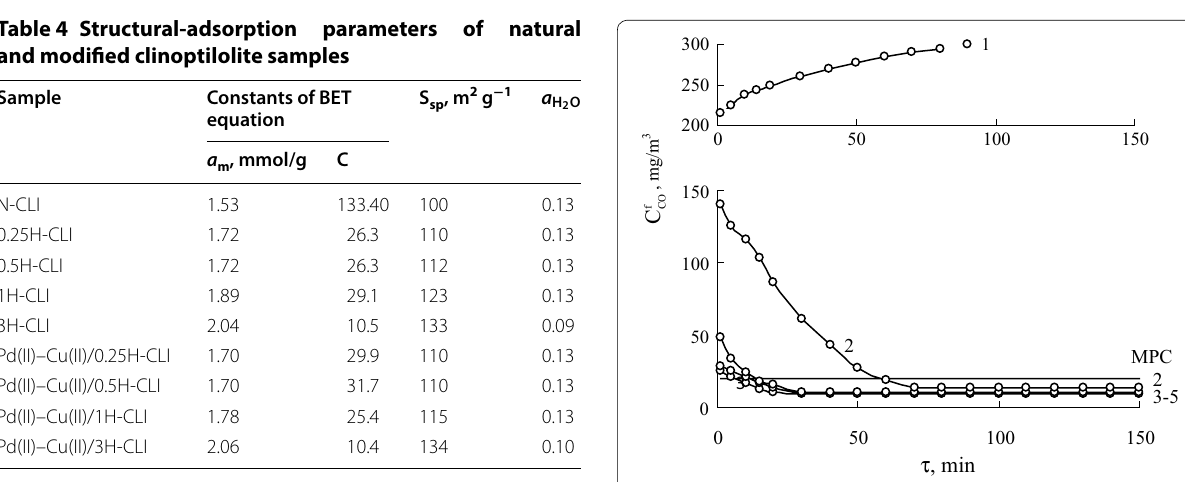
Fig. 5 Time dependence of C f CO in the course of CO oxidation